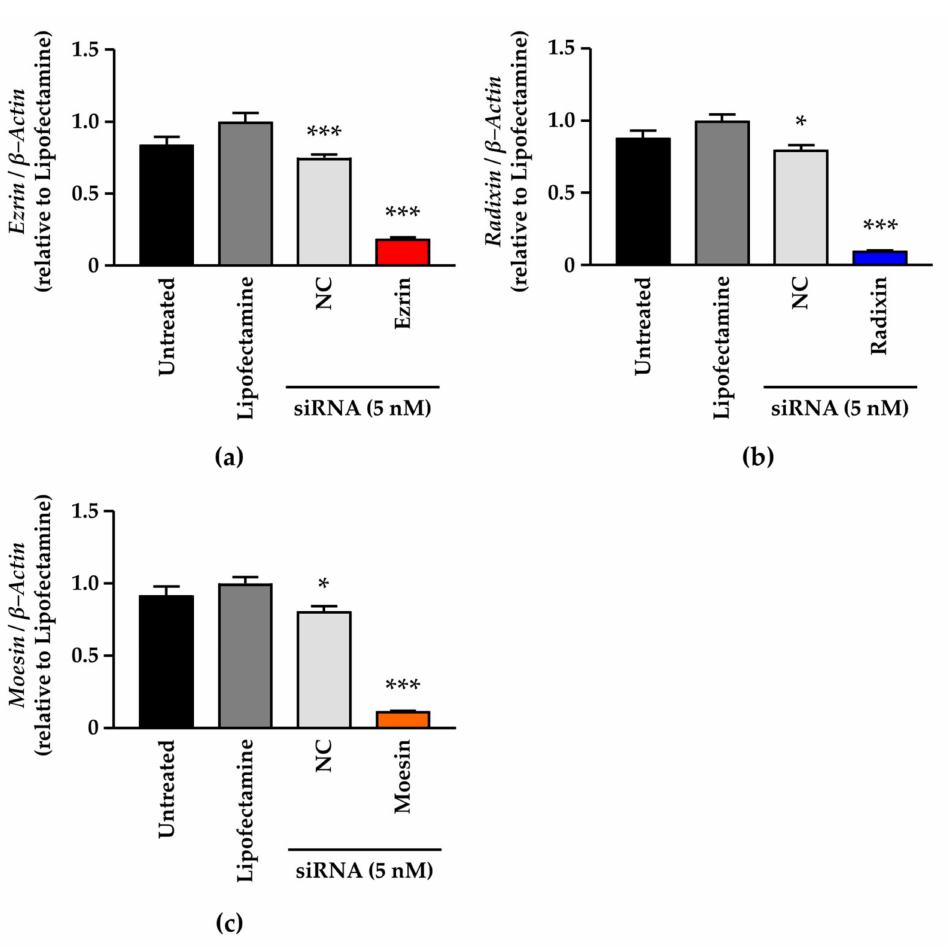
Figure 4. Effect of small interfering RNA against ezrin, radixin, or moesin on each target mRNA expression level in A2780 cells. Cells were cultured for 4 days with the medium (untreated), Lipofec- tamine, non–targeting control (NC) small interfering (si) RNA, and siRNAs against ezrin, radixin, or moesin at a concentration of 5 nM. Relative mRNA levels of ( a ) ezrin, ( b ) radixin, and ( c ) moesin normalized to β –Actin in cells treated with siRNAs relative to those in cells treated with Lipofec- tamine alone were measured using real-time reverse transcription–polymerase chain reaction. n = 3, *** p < 0.001, * p < 0.05 vs. Lipofectamine. All data are expressed as the mean ± SEM and were analyzed using one-way ANOVA, followed by Dunnett’s